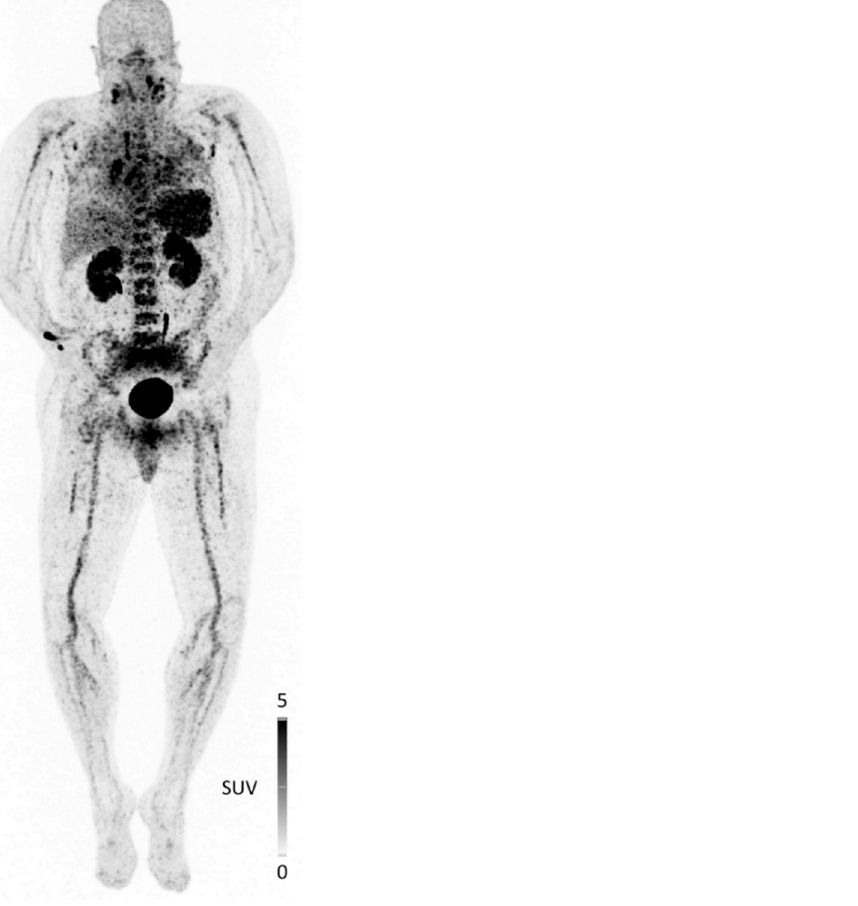
Figure 1. Maximum intensity projection of CXCR4-directed PET/CT with [ 68 Ga]Pentixafor in a 67-year-old patient with acute COVID-19 infection. Beyond bilateral pneumonia with reactive hilar and mediastinal lymph nodes, inflammatory foci in the lymphoid tissue of the neck could be depicted. In addition, the reactive activation of both bone marrow and spleen is visualized. The patient’s condition deteriorated quickly after imaging and he was transferred to the ICU on the day after PET/CT [C. Lapa, unpublished